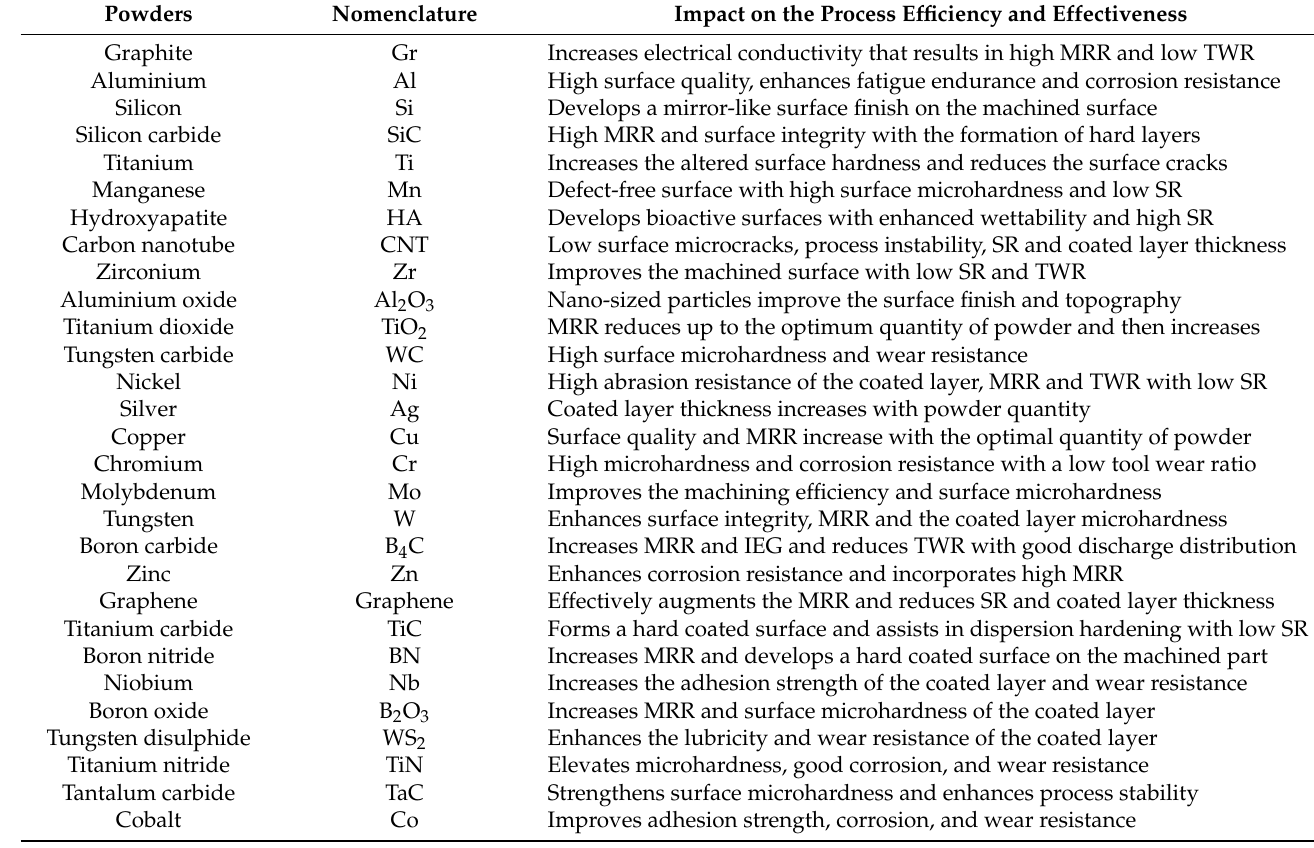
Table 1. Powders utilized in the PMEDM process over the last decade.